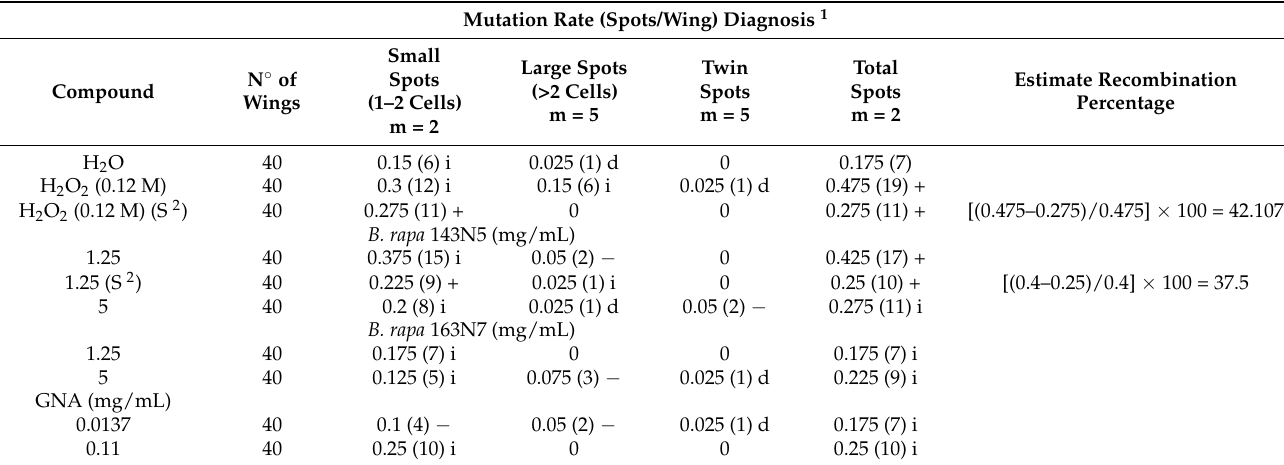
Table 4. Genotoxicity of Brassica rapa (Br) cultivars and gluconapin (GNA) in the Drosophila wing spot test. Mutation Rate (Spots/Wing) Diagnosis 1